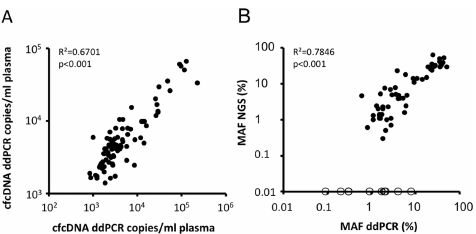
Fig 3. A. Correlation between total circulatingcell-free DNA copies per ml of plasma measuredby dPCR and qPCR in 87 plasma samples of 61 metastatic NSCLC patients. B. Correlationbetweenmutant allelefraction (MAF) measuredfor sensitizing and resistancemutations by dPCR and NGS. Empty circles represent samples not detected by